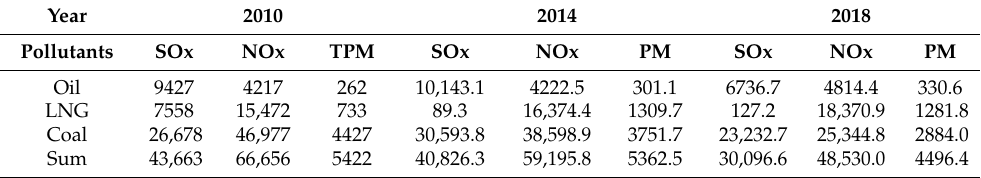
Table 2. Air pollution emission (TPY) from the fossil-fuel power generation sector in